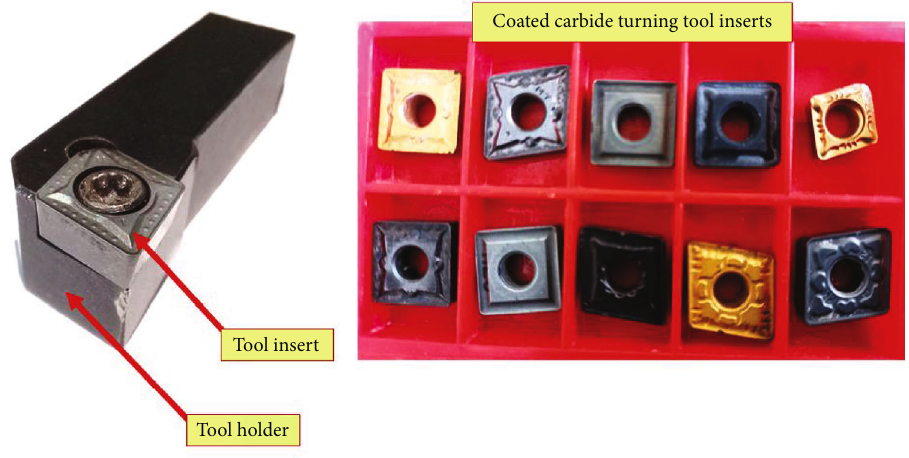
Figure 1: Tool insert, tool holder, and types of coated carbide tool